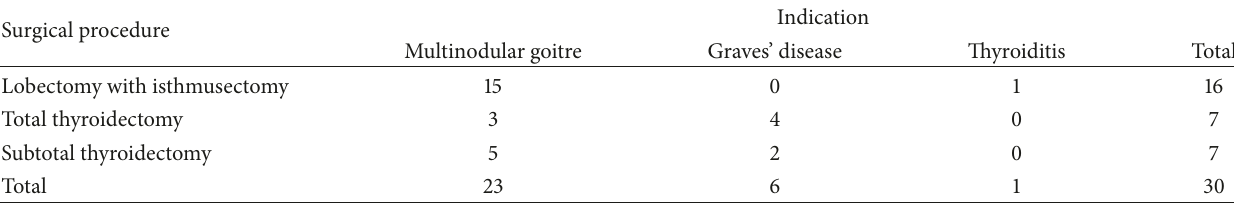
Table 1: Surgical attitude according to the indications during the first thyroidectomy. Surgical